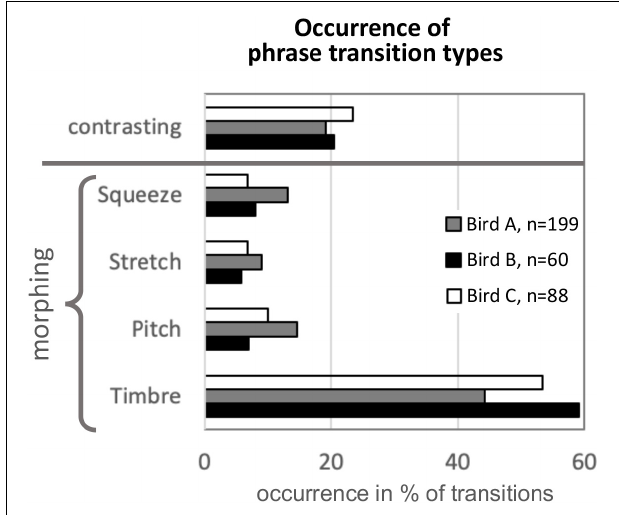
FIGURE 9 | Occurrence of modes of morphing in song excerpts of three birds. Based on human auditory judgment (exploratory quantification by one observer), every phrase transition was assigned the most fitting morphing category, or the label “contrasting” if there was no salient morphing, i.e., low similarity between the pre- and post-transition phrase. Morphing mode “Timbre,” in which timbre is changed from pre- to post-transition while other syllable features stay mostly similar, was the most common, covering around 50% of all transitions. In only around 20% of transitions, pre- and post-transition syllables were dissimilar/contrasting. n indicates number of phrase transitions analyzed. Note that this analysis was based on a subset of phrases from birds A, B, and C (number of transitions analyzed are indicated in the